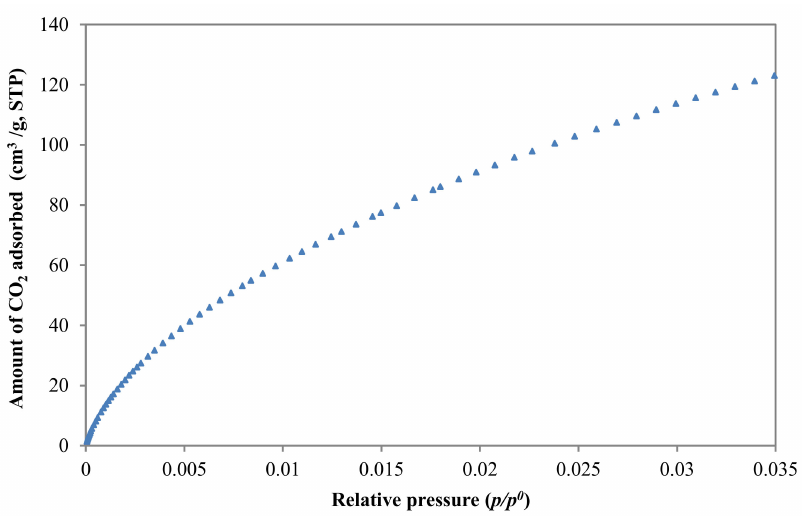
Figure 3. Adsorption isotherms of CO 2 at 0 ◦ C for the synthetized